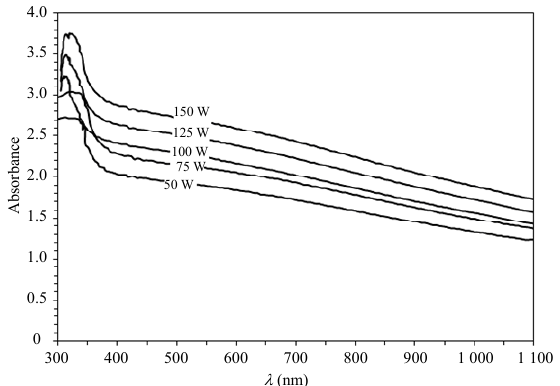
Fig. 4 Absorbance as a function of wavelength for (Ti6Al4V) thin film at different working RF powers.